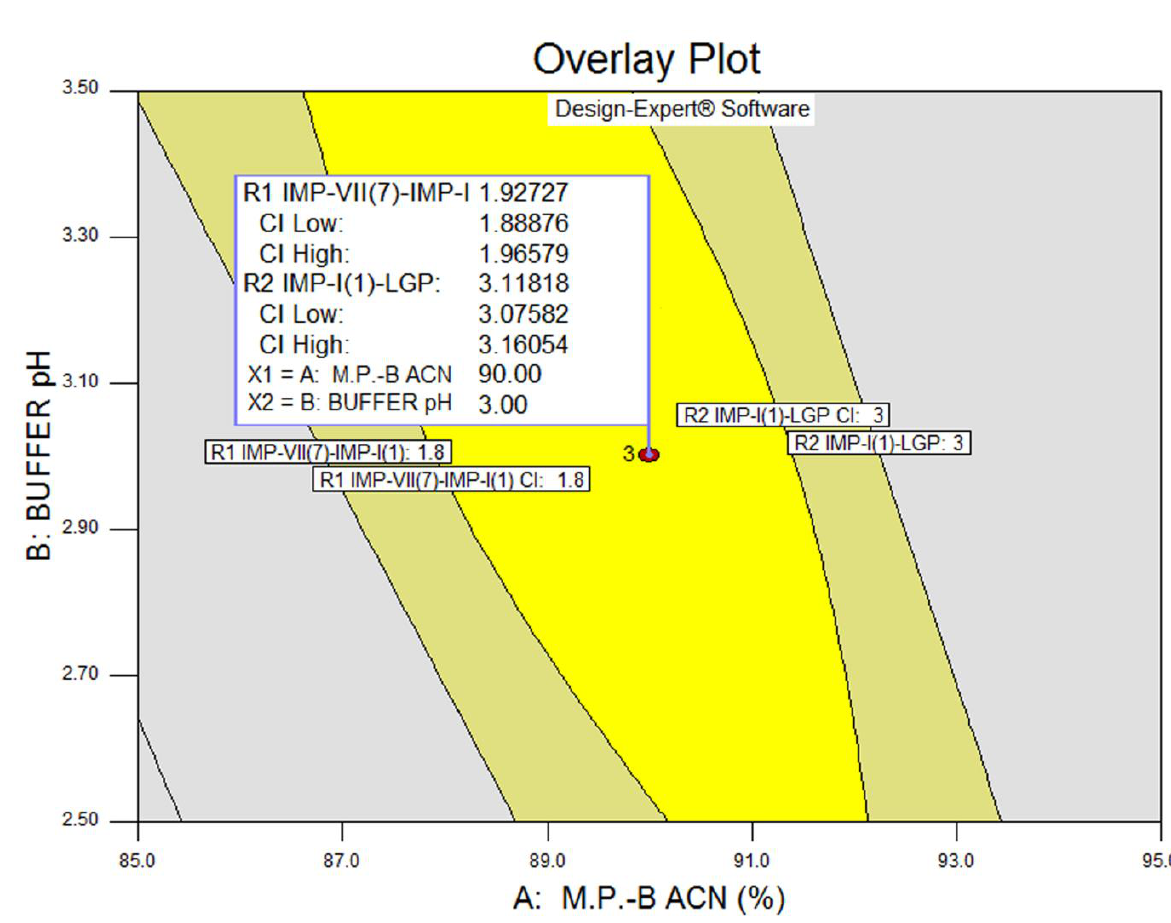
Figure 3. Overlay Plot with confidence interval (CI).